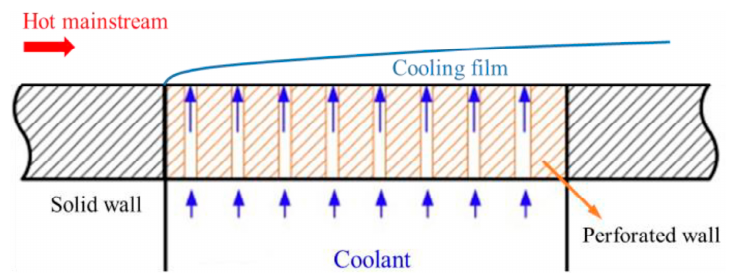
Figure 6. Schematic diagram of effusion cooling principle.